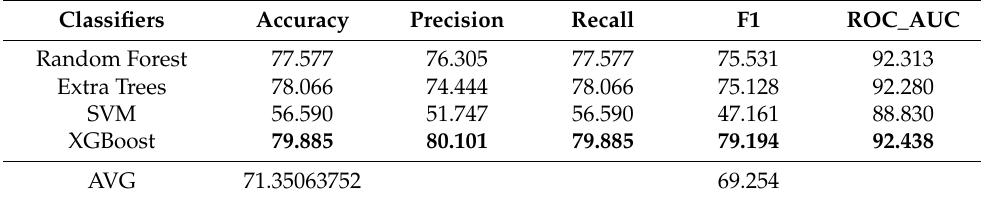
Table 4. HYBRID Raw Experimental Results.